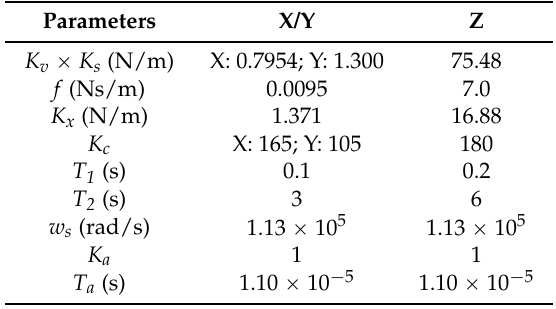
Table 3. Model parameters of the MESA operated at atmospheric pressure.